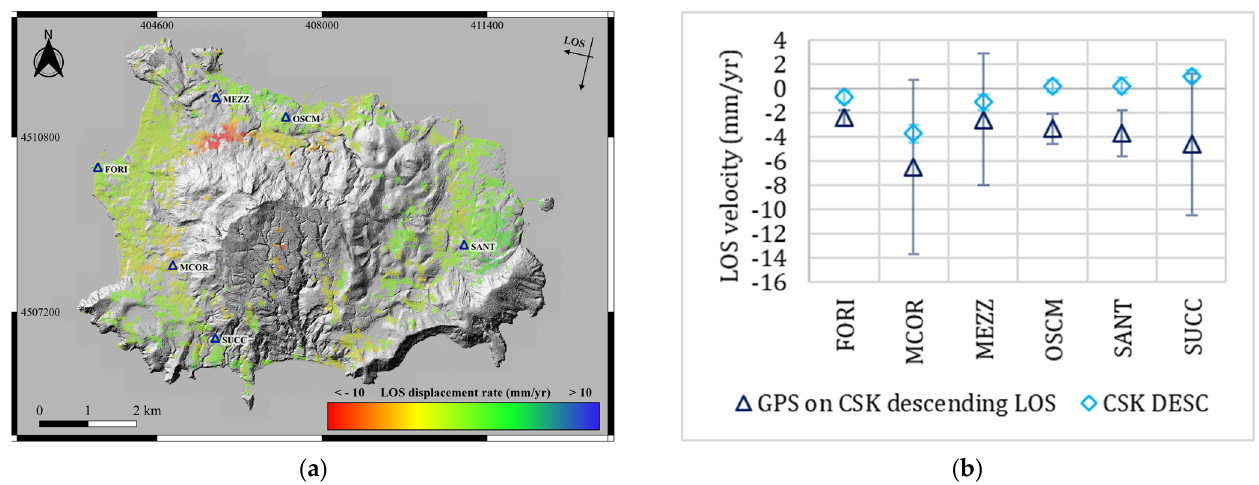
Figure 5. ( a ) Descending displacement map computed by using COSMO-SkyMed data. ( b ) Comparison between GPS displacement rates reprojected on satellite LOS (blue triangles) and those ones retrieved by SBAS processing (light blue diamonds).